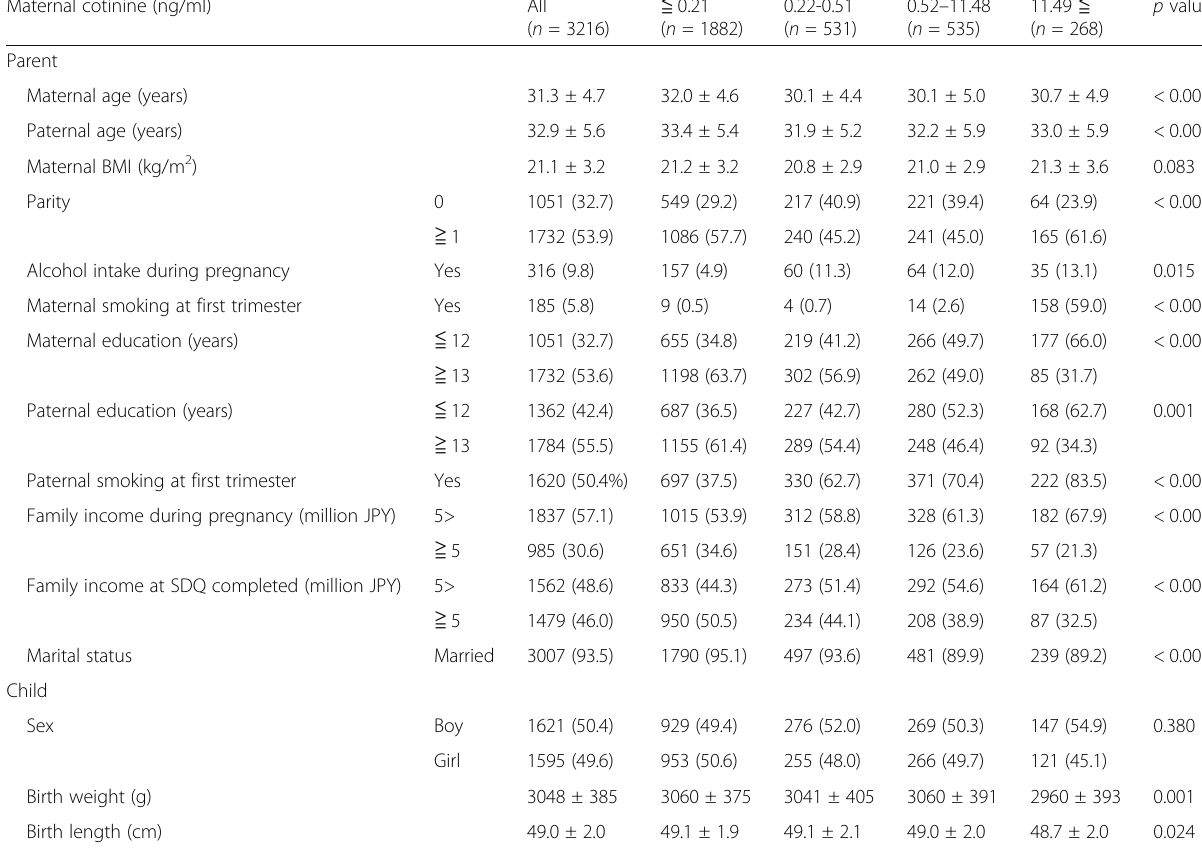
Table 1 Characteristics of the study population according to maternal cotinine levels Maternal cotinine